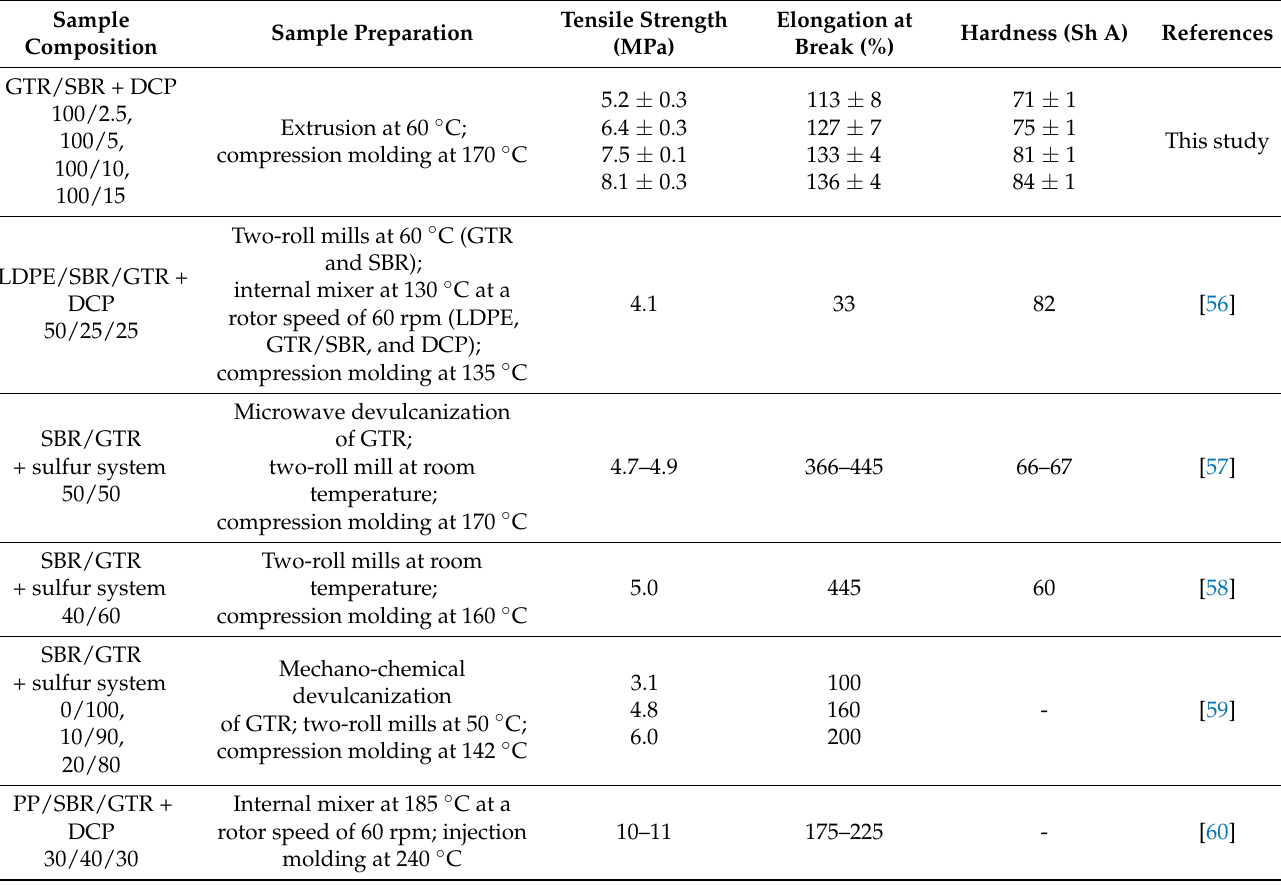
Table 5. Comparison of tensile properties of GTR/SBR blends described in the